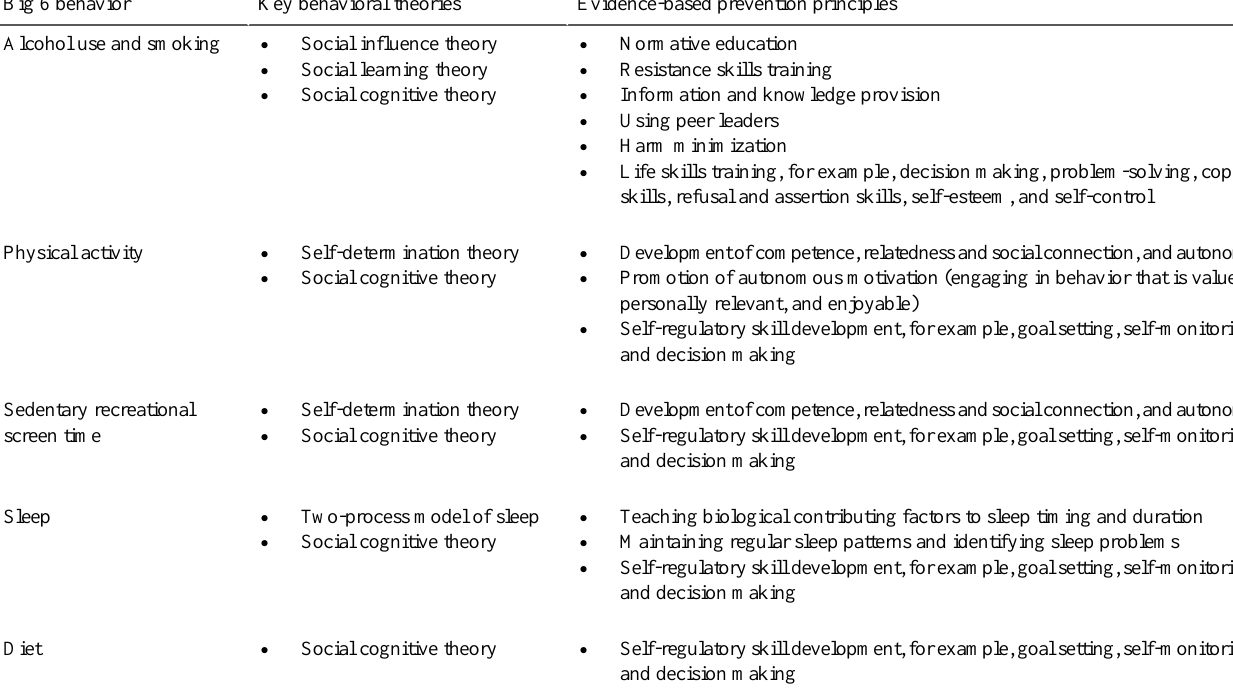
Table 1. Key behavioral theories and evidence-based prevention principles for each of the Big 6